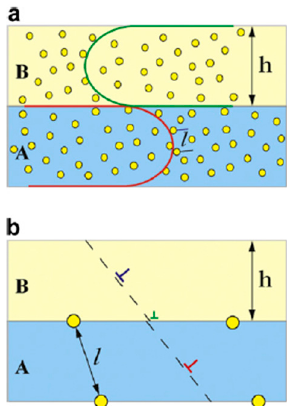
Figure 20. Schematic illustration of the length scale dependent deformation mechanism in multilayers after He irradiation. ( a ) When h is much larger than l , the deformation is via CLS with dislocations pinned by nanometer-scale bubbles. ( b ) When h is much smaller than l , the yield strength is determined by the crossing of single dislocation across interfaces, which contains a number of nanometer-scale He bubbles in the interface plane [96].